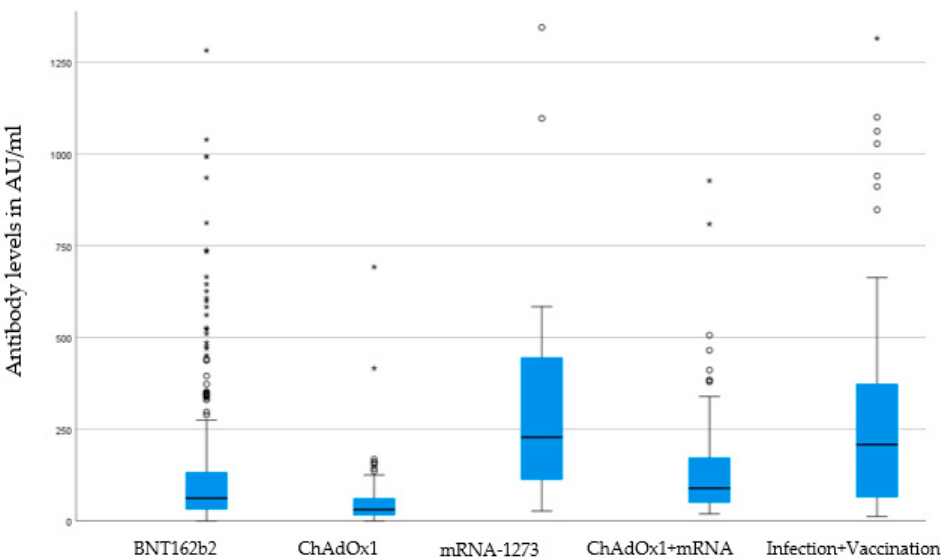
Figure 2. Boxplot of antibody levels according to vaccines. Boxes show median and interquartile range (IQR) between 25% quartile (Q1) and 75% quartile (Q3), whiskers (lower whisker Q1 − 1.5*IQR and upper whisker Q3 + 1.5*IQR), outliers (asterisks), and extreme values (circles). Analysis of sta- tistical significance p < 0.001 (Kruskal-Wallis-test). BNT162b2 (Pfizer–BioNTech), mRNA -1273 (Moderna), and ChAdOx1 (AstraZeneca). Table 3. Multivariate analysis of influencing factors being below the threshold of 54